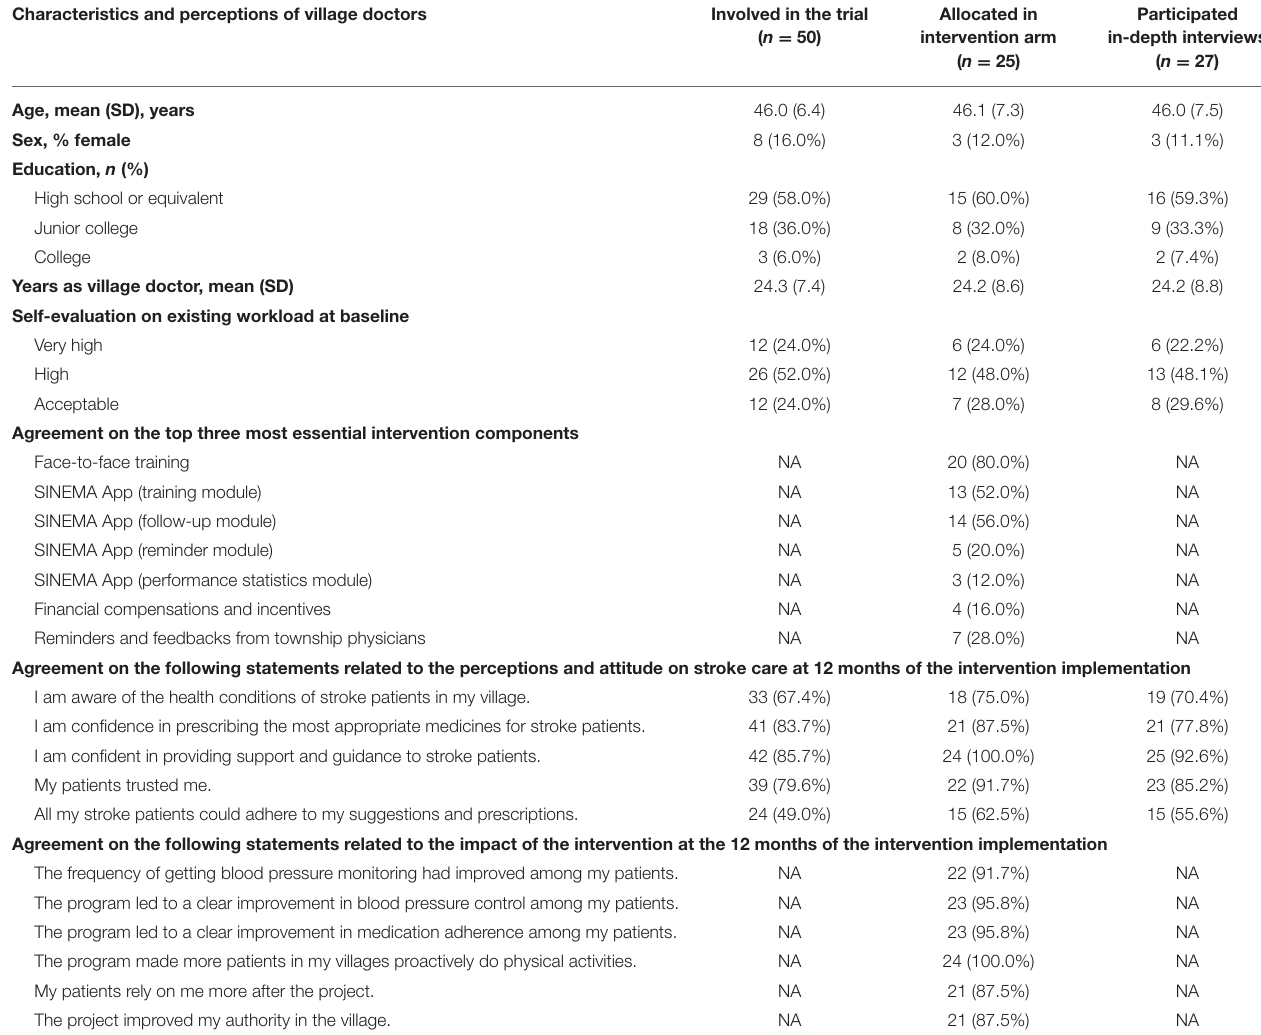
TABLE 3 | Characteristics of village doctors who were involved in trial, implemented the SINEMA intervention, and participated in the in-depth interviews and their perceptions of stroke care and SINEMA intervention components. Characteristics and perceptions of village